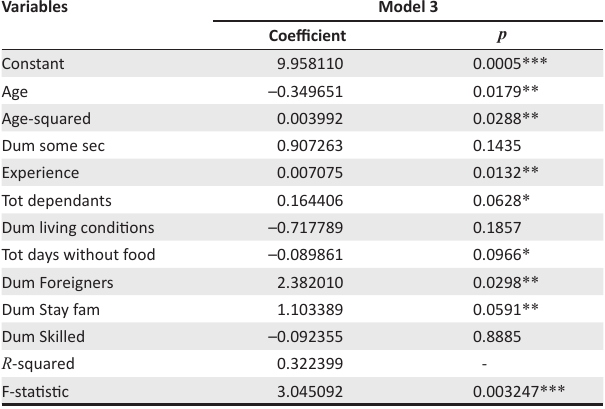
TABLE 6: Windhoek day labourers’ subjective well-being regression 3 results.